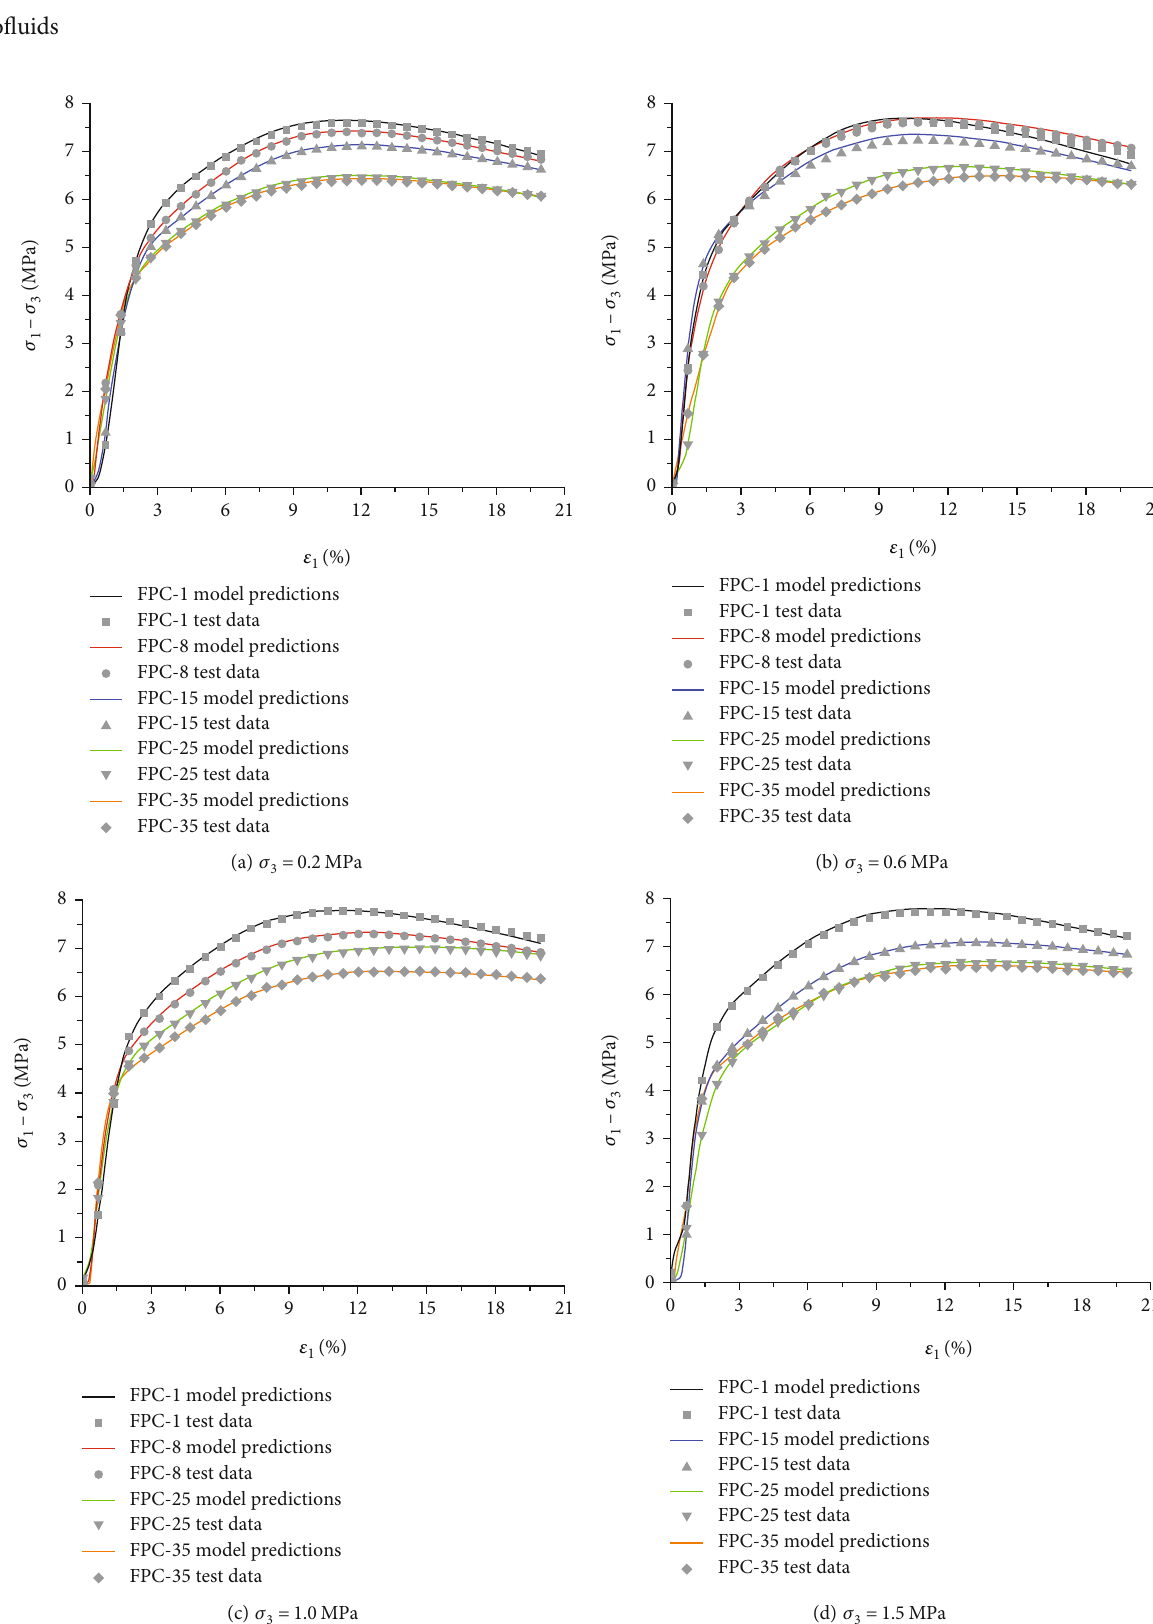
Figure 11: Comparison between model predictions and the test data under di ff erent con fi ning